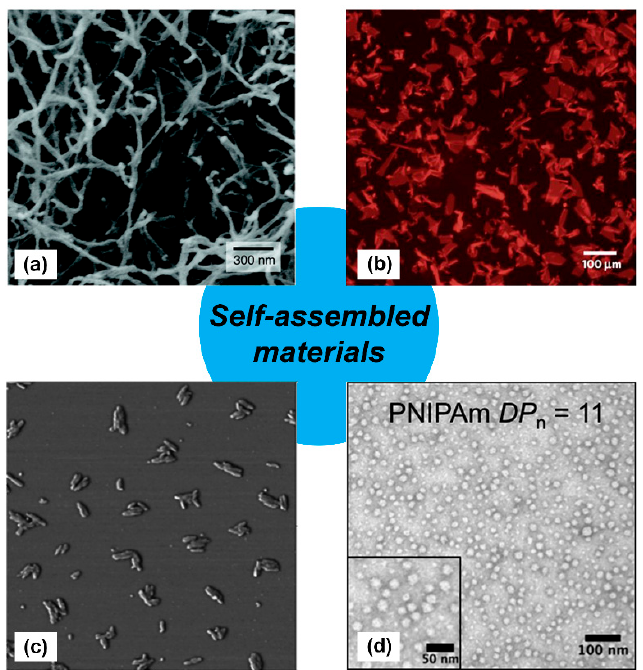
Figure 1. Examples of self-assembled materials with different morphologies. ( a ) Scanning electron micrograph of an isoluecine–lysine–valine–alanine–valine (IKVAV)-containing peptide nanofiber network formed by adding cell media (Dulbecco’s modified Eagle medium; DMEM) to an aqueous solution of a peptide amphiphile. Adapted with permission from [11]. Copyright 2004, Science publishing. ( b ) Fluorescence photomicrograph of individual two-dimensional (2D) crystalline sheets assembled from periodic amphiphilic peptoid polymers. Adapted with permission from [12]. Copyright 2010, Nature publishing. ( c ) Atomic force microscopy (AFM) phase image of small rods derived